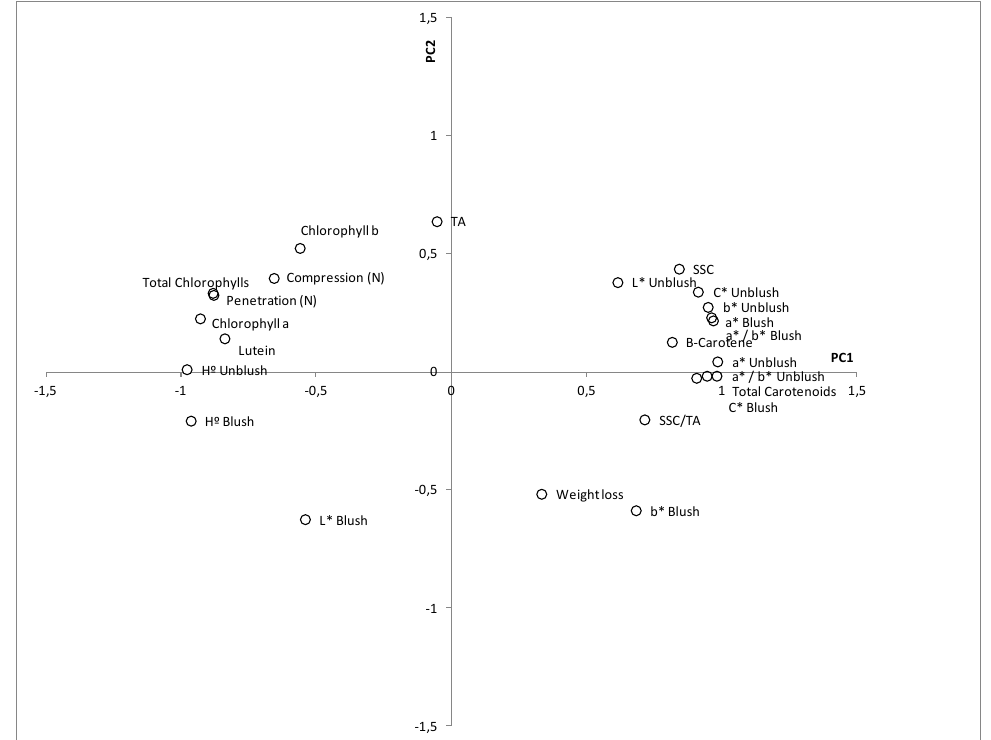
Agriculture 2021 , 11 , x FOR PEER REVIEW Figure 10. Parameters on the PCA plane (PC1: 67.2% of total variance; PC2: 11.9% of total variance). When the samples are represented on the plane defined by the first two principal components (Figure 11), the different positions can be observed, depending on the cul- tivar, harvesting date, and shelf-life period. ‘Spring Blush’ and ‘Robada’ appear on the